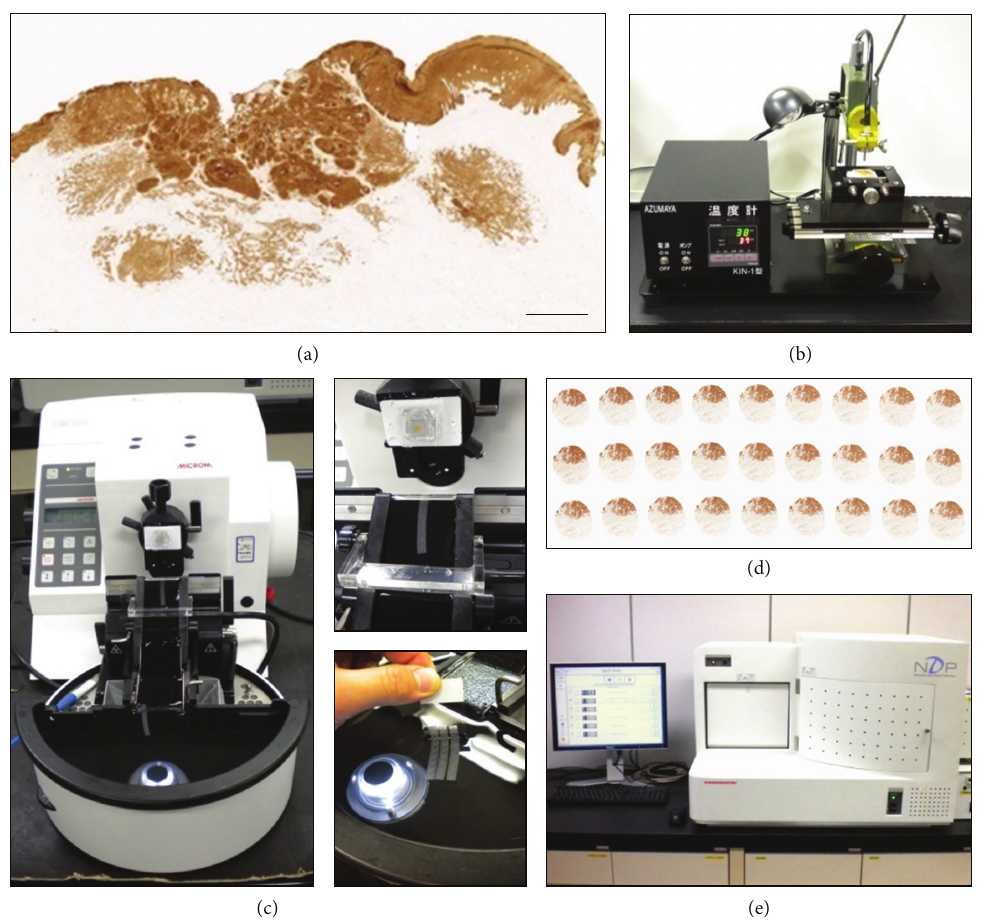
Figure 1: (a) Original pan-cytokeratin-stained image of an OTSCC lesion. Bar = 1mm. (b) Tissue-array apparatus used to collect a core biopsy of 3mm in diameter from the deepest invasion front (see Plate S1). (c) Preparation of serial sections (4 𝜇 m thick) from the core specimen using a rotary microtome. The serial sections were conveyed via continuous laminar water flow directly from the knife edge to the heated water bath. (d) Three rows of 9 sections were mounted on each glass slide for immunostaining with Ki67 and CK cocktail. (e) All histological images were digitized using virtual